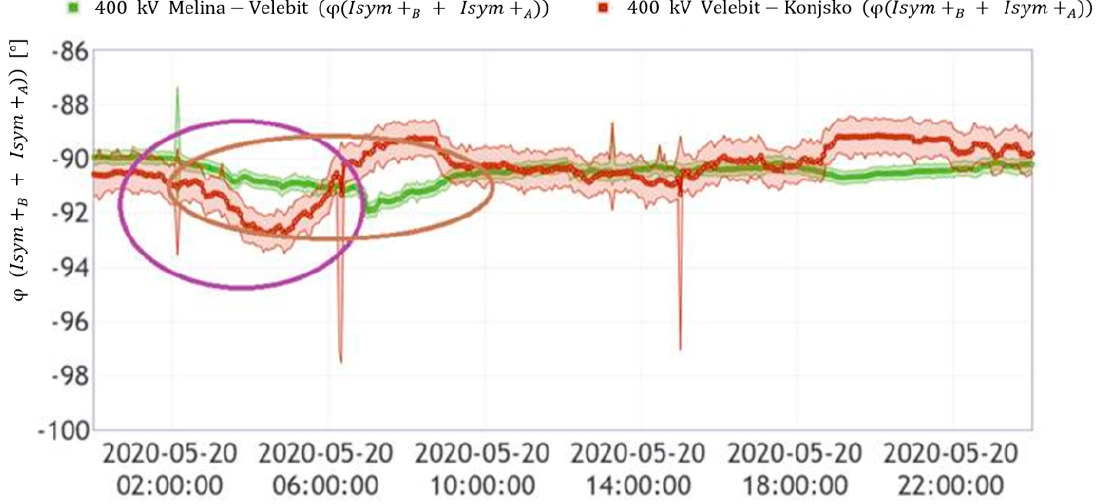
Figure 6. Differential current angles of the Melina-Velebit and Velebit-Konjsko 400 kV lines during a period of 24 h on 20